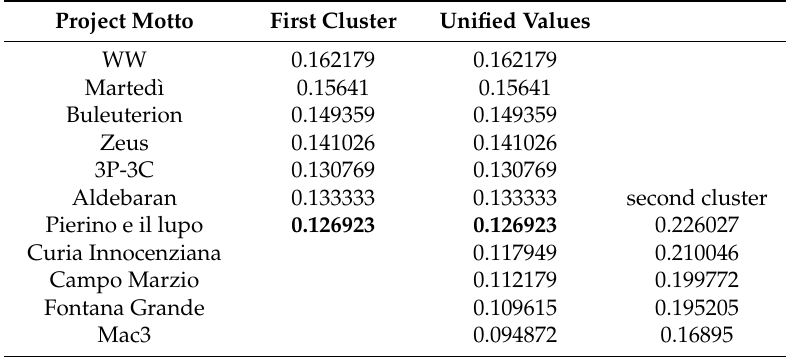
Table 9. Example of the qualitative criterion “architectural quality”—clusters and pivot element. Project Motto First